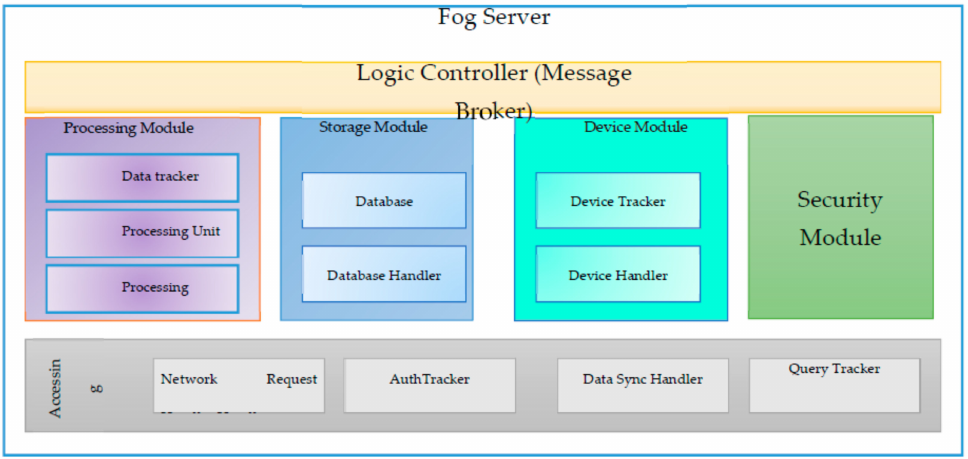
Figure 4. Detailed architecture of the fog